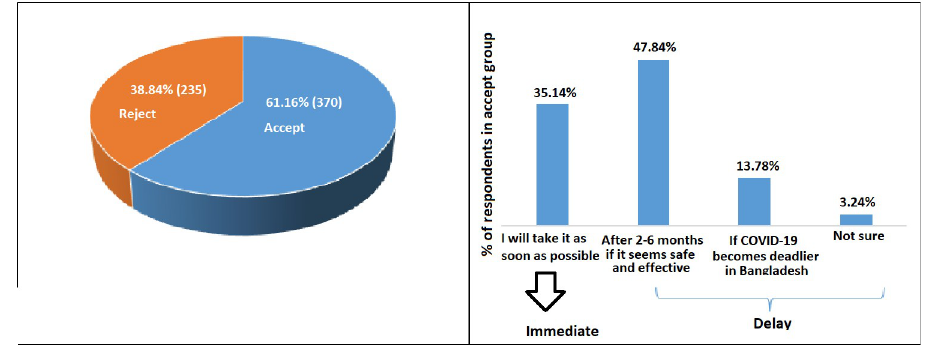
Fig 1. The acceptance of COVID-19 vaccine in Bangladesh.